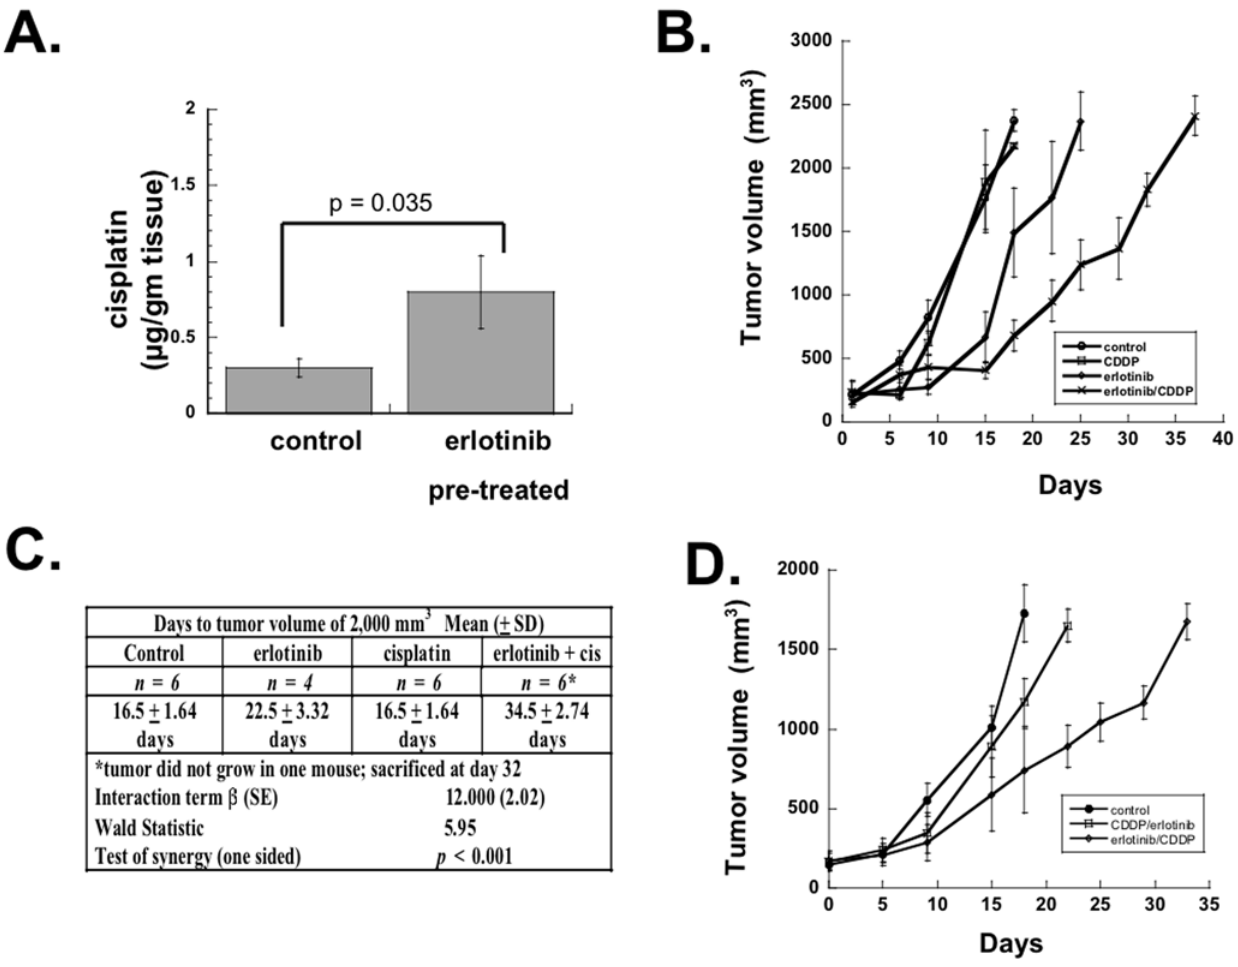
Figure 5. Effect of erlotinib with cisplatin on tumor regrowth of xenografts. (A) Mice were subcutaneously implanted with SQ20B cells. When tumors reached a size of , 5 mm in diameter, therapy was started. One group of mice (five mice) received a single dose of cisplatin (CDDP) intraperitoneally (1 mg/kg). Three hours later, the mice were sacrificed, and tumors were removed and snap frozen in liquid nitrogen. The second group of mice was fed an erlotinib-containing diet, and then on day 5 the mice were injected with CDDP intraperitoneally (1 mg/kg). Three hours later, the mice were sacrificed, and tumors were removed and snap frozen in liquid nitrogen. (B) Mice were subcutaneously implanted with SQ20B cells. When tumors reached a size of , 5 mm in diameter, therapy was started. One quarter of the mice received no therapy (control). One quarter received a single dose of cisplatin (CDDP) intraperitoneally (1 mg/kg) on Day 1. One quarter received erlotinib feed on days 1 through 4 and the morning of day 5 followed by a single dose of CDDP on day 5. One quarter received erlotinib feed starting on day 1 and continuing through the morning of day 5 but no CDDP. Erlotinib was not given from day 6 onward for any group. (C) Test of synergy for regrowth delay in time to reach tumor volume of 2,000 mm 3 (D) Mice were subcutaneously implanted with SQ20B cells. When tumors reached , 5 mm in diameter, a third of the mice were given a single injection of CDDP (on Day 1) then later that day started on an erlotinib-containing diet that continued through day 5. A third of the mice were given erlotinib feed on days 1 through 4 and the morning of day 5 followed by a single dose of CDDP on day 5. Erlotinib was not given from day 6 onward for any group. A third received no therapy (control). Mean tumor volume 6 standard deviation of time to reach 1,250 mm 3 were 16.5 6 3.21, 17.1 6 4.22 and 26.0 6 6.40 days for control, CDDP - . erlotinib, erlotinib - . CDDP groups respectively. The three groups were significantly different (p=0.0001; ANOVA) with the erlotinib - . CDDP group having a significantly longer time period as compared with both control (p=0.003) and CDDP - . erlotinib (p=0.006)